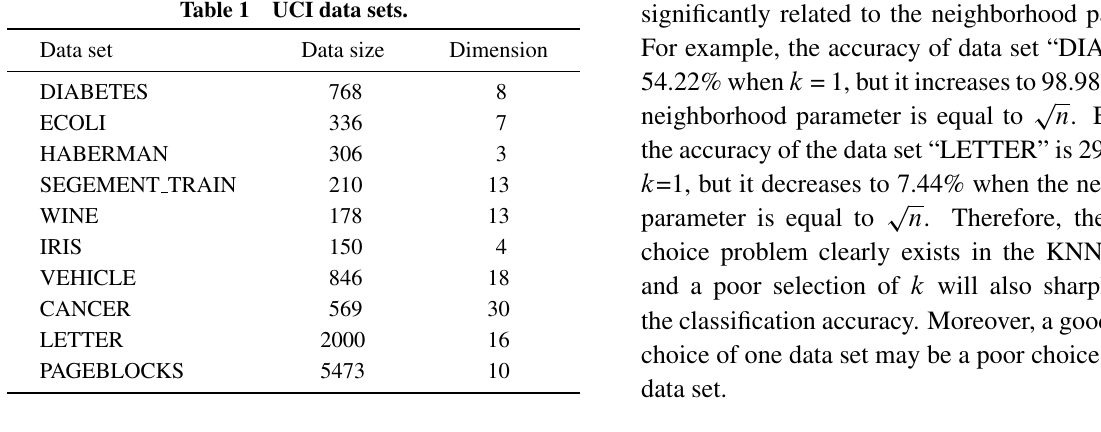
Table 2 Classification accuracies of KNN algorithms over a range of k , ENN algorithm ( k =3), and NNBCA algorithm with no neighborhood